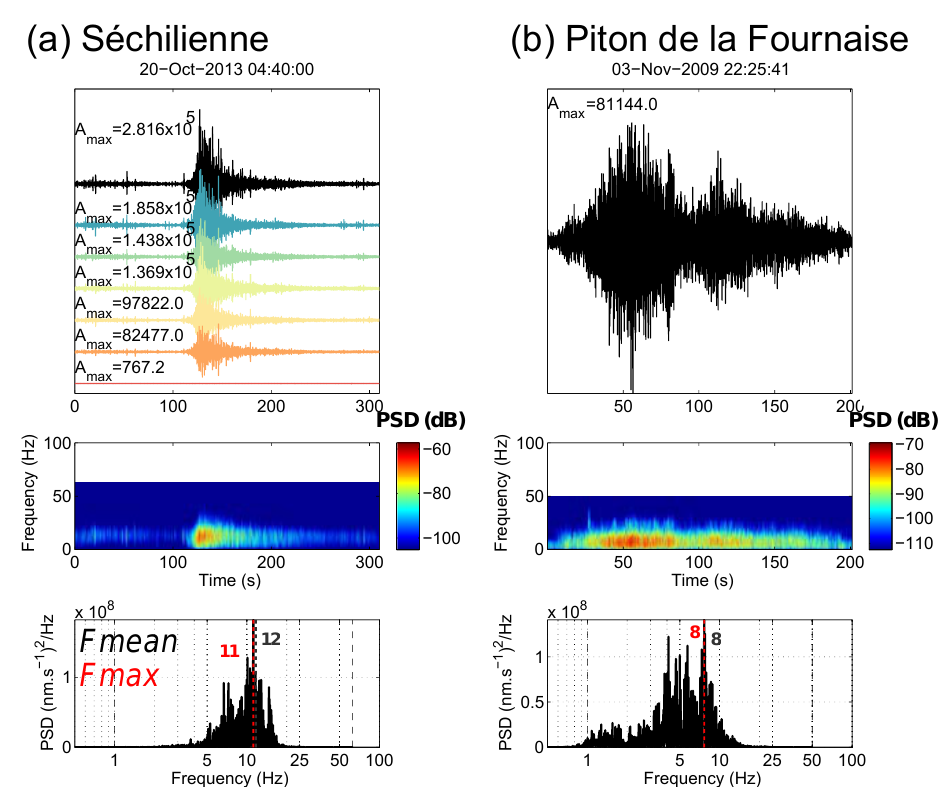
Figure 4. Dry granular flow events recorded at (a) Séchilienne and (b) the Piton de la Fournaise caldera. See Fig. 2 for a description of the